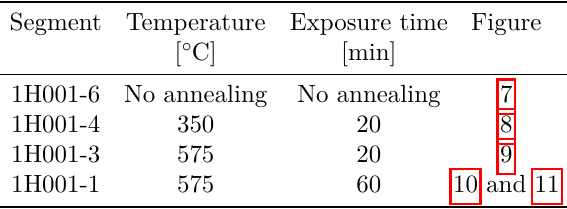
Table 2. The sample 1H001, annealing